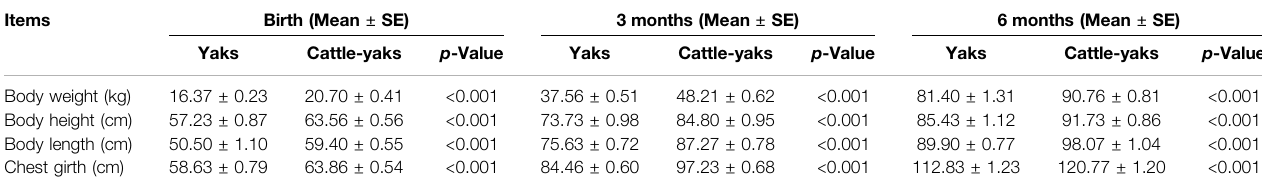
TABLE 1 | The production performance between cattle-yaks and